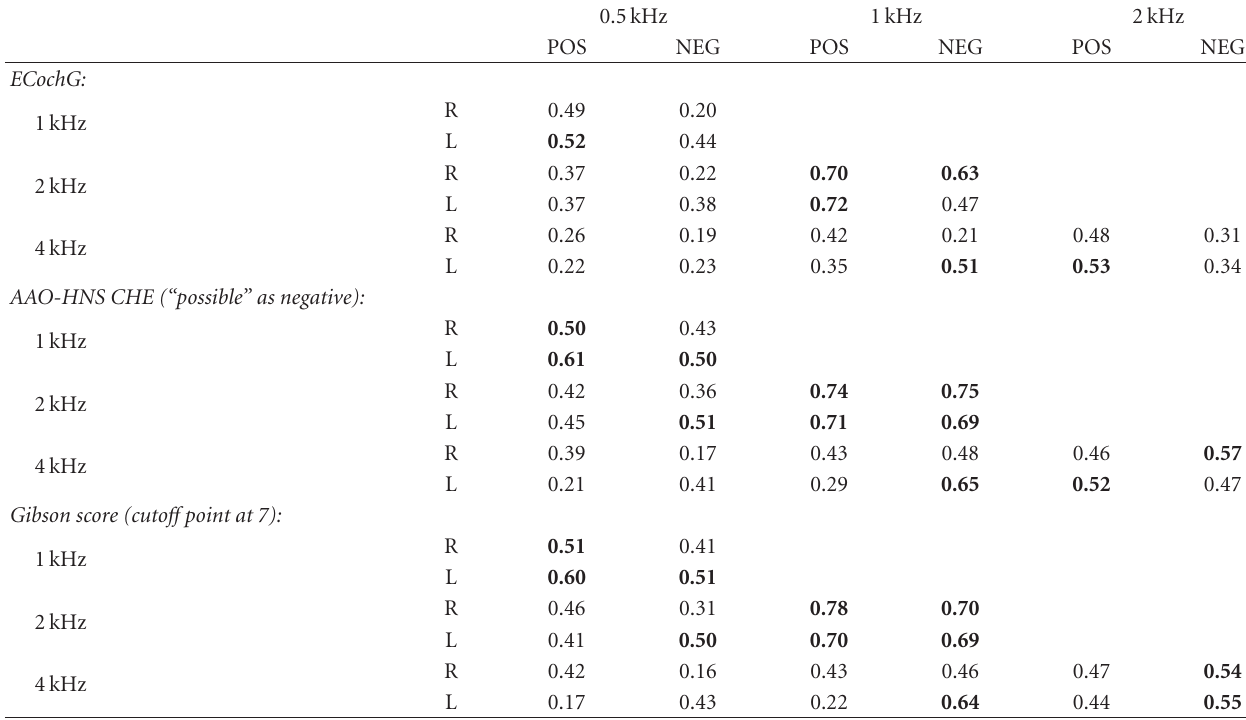
Table 6: Correlations (Pearson’s r) between SP/AP ratios obtained at 0.5, 1, 2, and 4kHz in the “positive” (POS) and “negative” (NEG) cases classified by three diagnostic